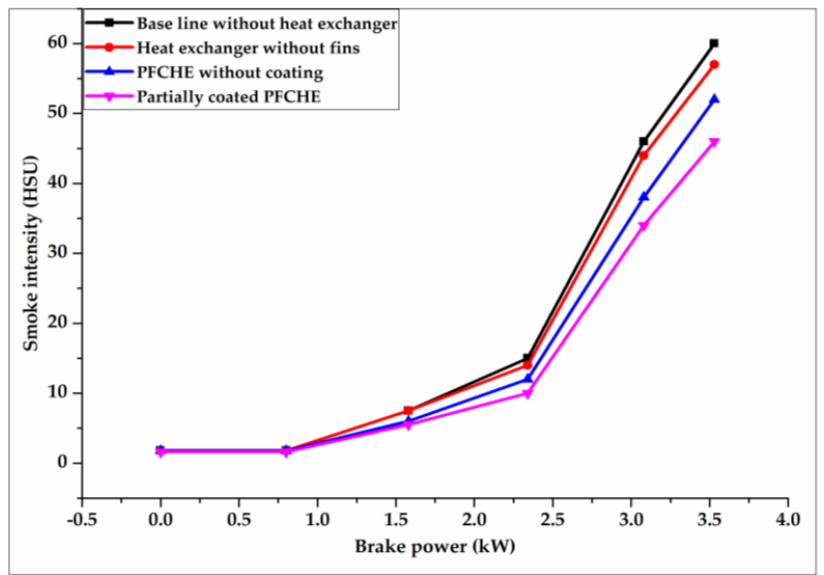
Figure 12. Effect of heat exchanger on CO 2 emission.